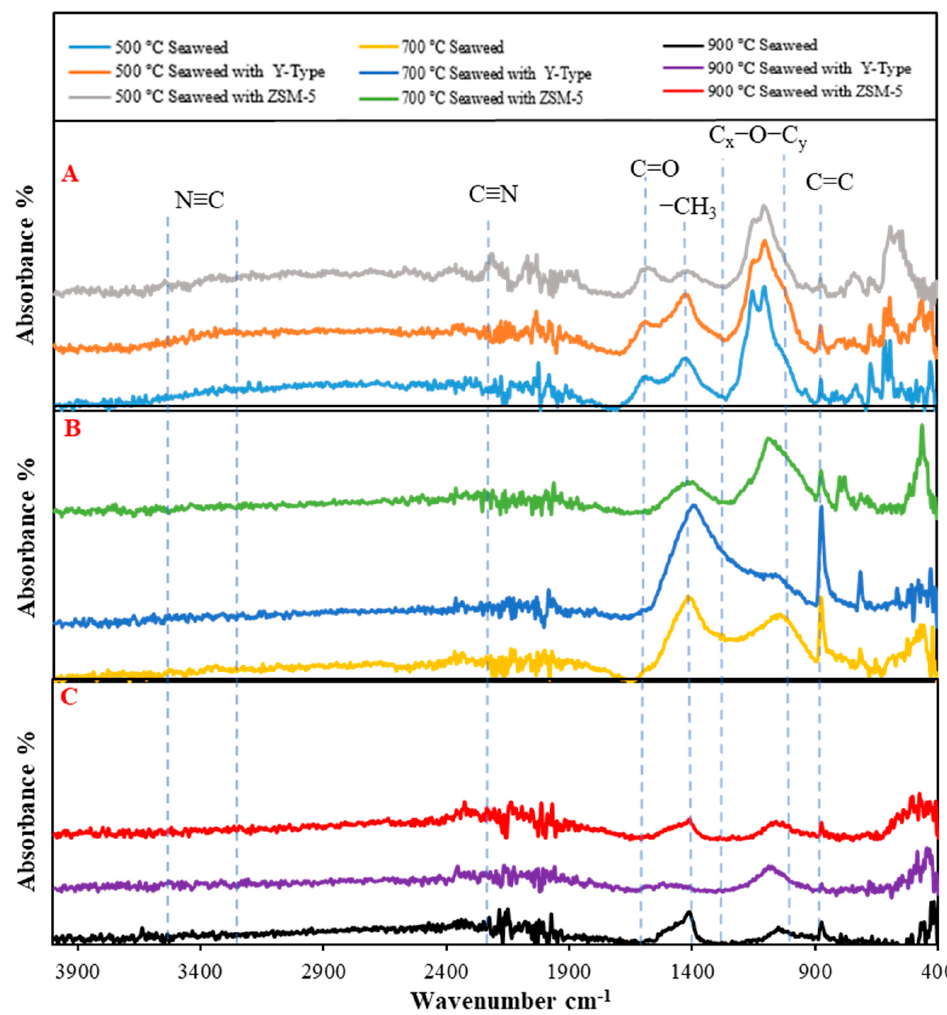
Figure 9. FTIR spectra of solid products by seaweed pyrolysis. ( A – C ) Pyrolysis temperatures of 500 °C, 700 °C, and 900 °C, respectively.